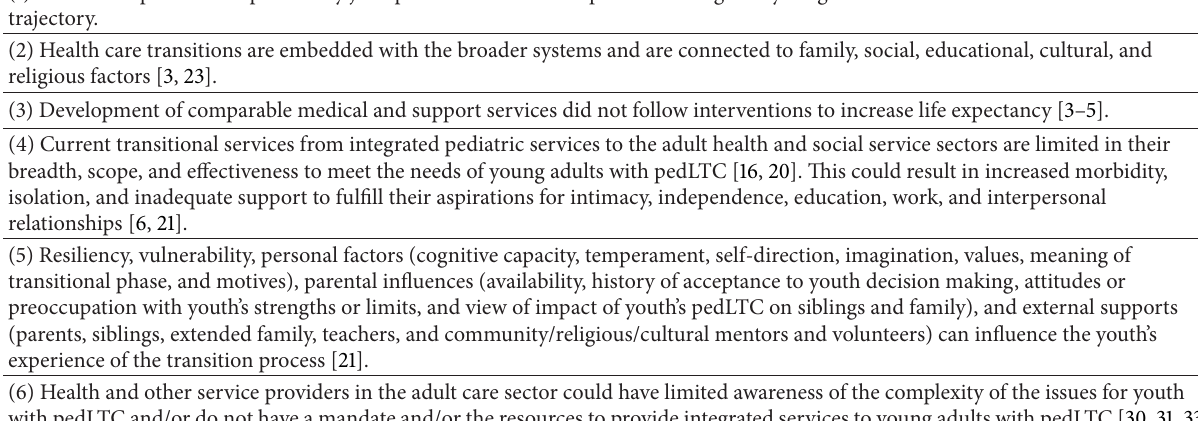
Table 1: Propositions: up against the